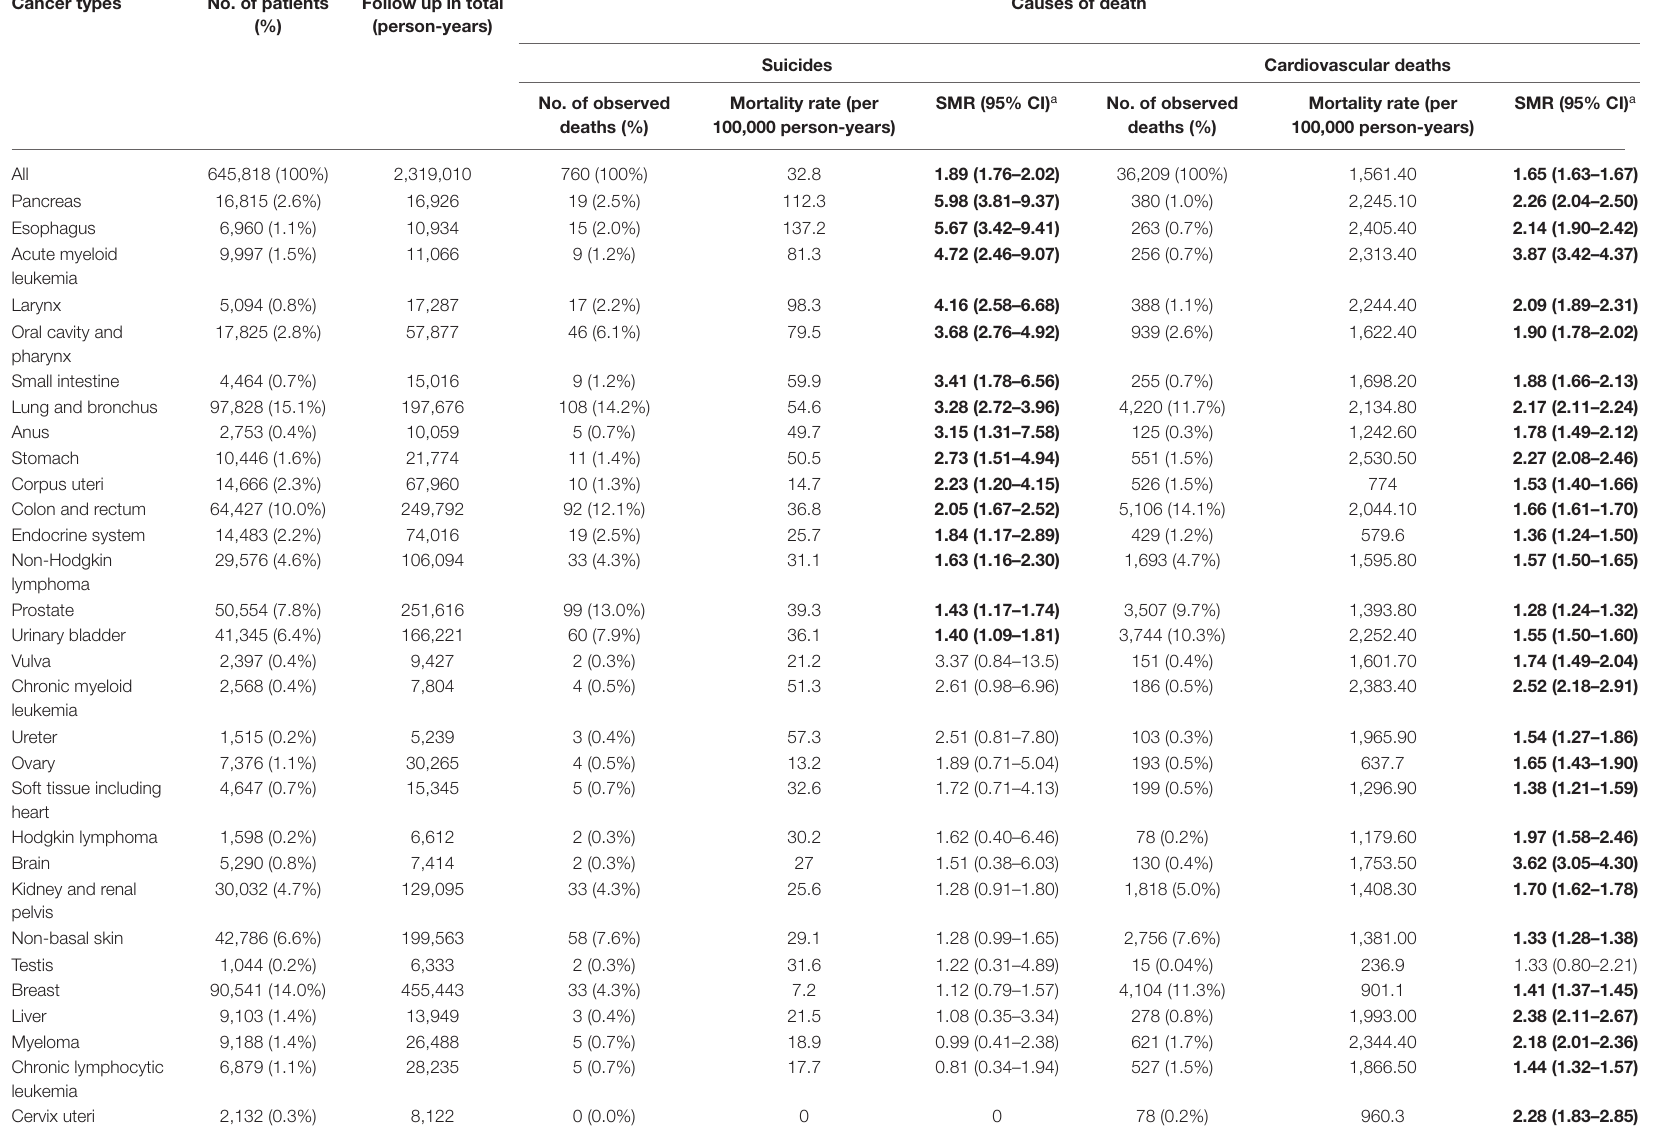
TABLE 3 | Suicide and cardiovascular deaths among patients with multiple primary cancers by cancer